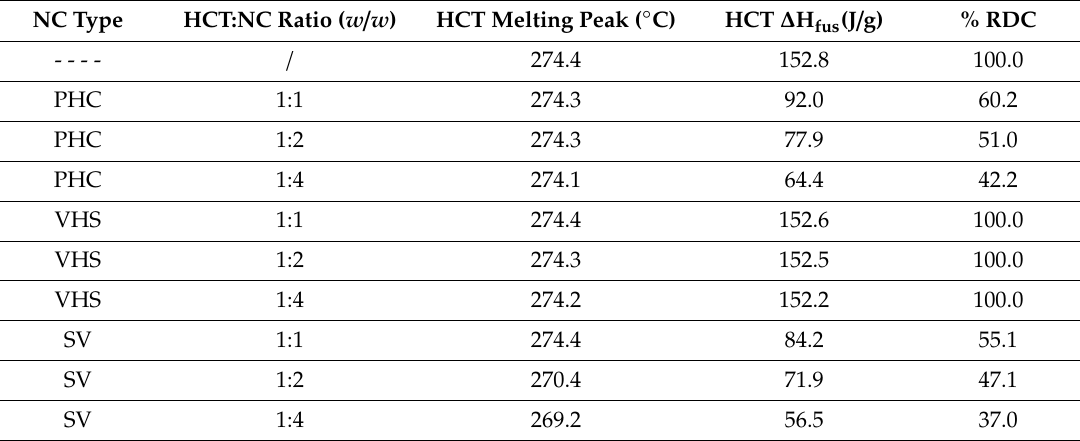
Table 2. Thermal parameters and % residual drug crystallinity (% RDC) of hydrochlorothiazide (HCT) alone or in the presence of the di ff erent examined nanoclays (NCs).